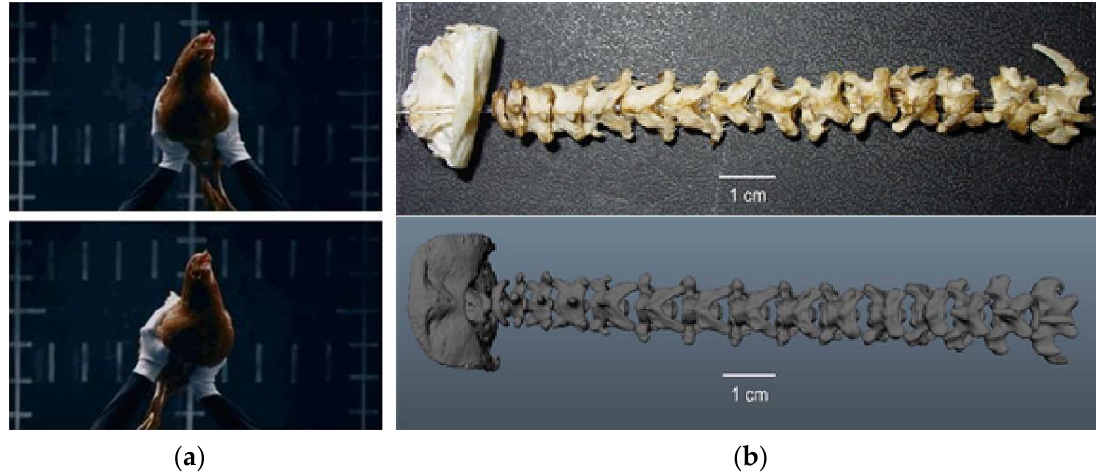
Figure 13. ( a ) Test of head’s gazing stability, ( b ) 3D reconstruction model of the neck [64].